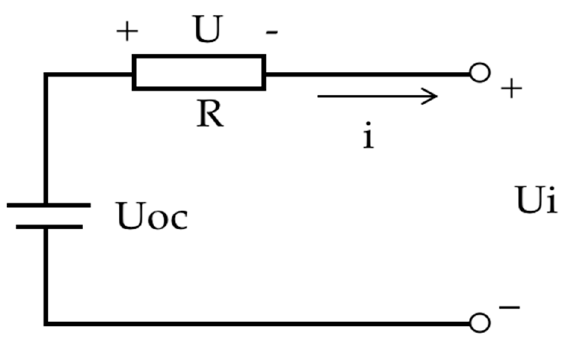
Figure 5. The R int battery equivalent model.